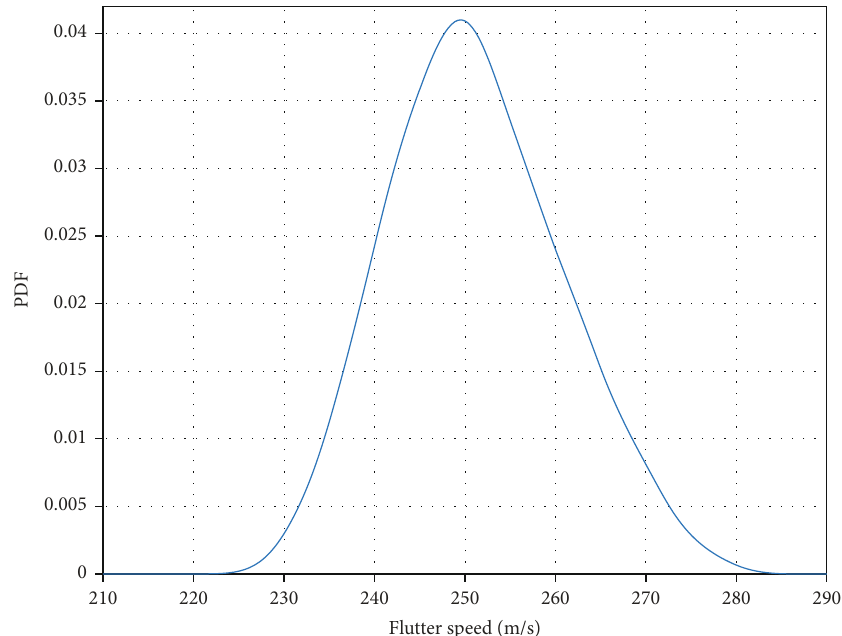
Figure 19: PDF of fl utter speed: deviations in the positions of EPs and